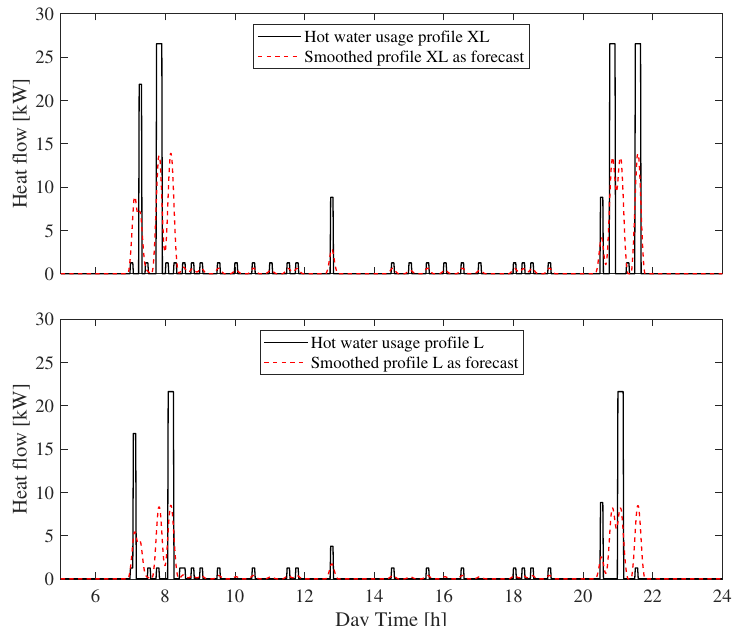
Figure 7. Original hot water usage profile, XL and L, with an energy demand of 19.07 kWh and 11.655 kWh per day and smoothed profiles for PMS applications, based on data extracted from